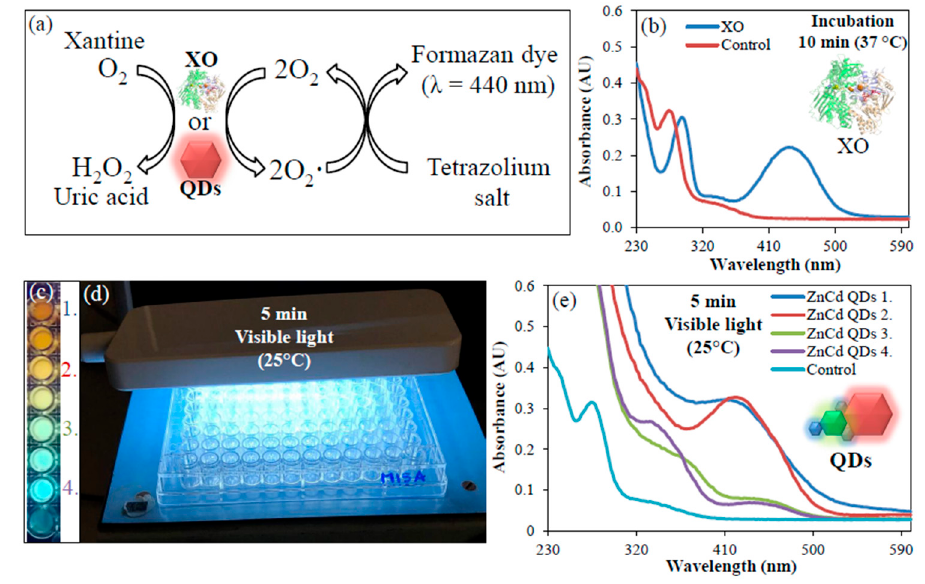
Figure 3. XO-like activity of ZnCd QDs. ( a ) Scheme of the XO activity ( b ) Absorption spectra of the XO substrate (blue trace) and distilled water (red trace) incubated with XO for 10 min at 37 °C ( c ) ZnCd QDs selected for monitoring of XO-like activity from Figure 2a ( d ) Photograph of visible light irradiation of mixture of ZnCd QDs with XO substrate ( e ) Absorption spectra obtained from XO substrate mixed with ZnCd QDs and irradiated for 5 min by visible light.